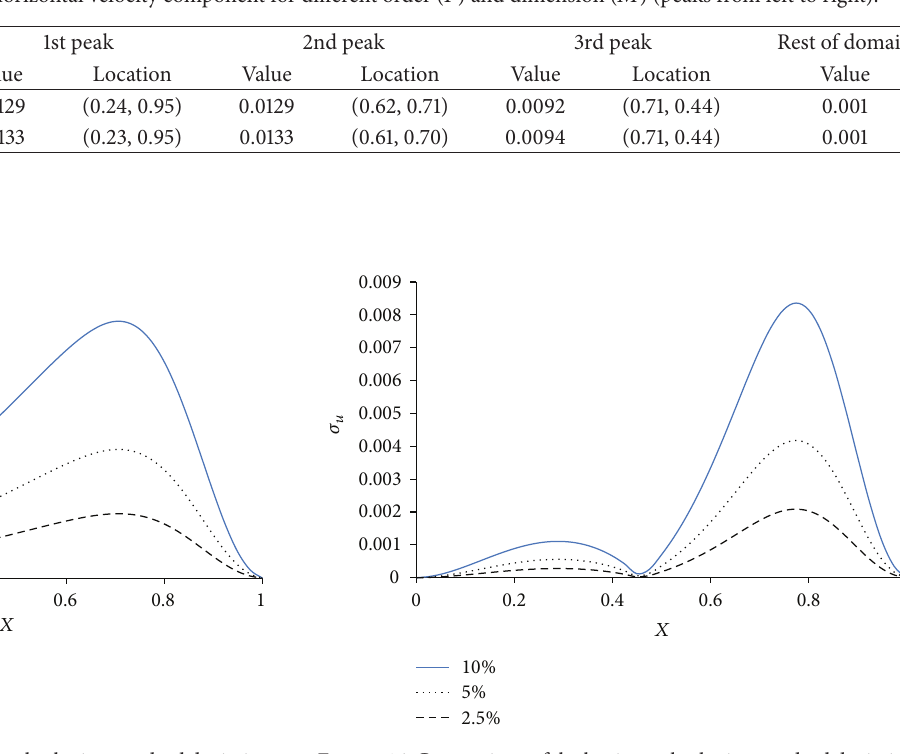
Figure16:Comparisonofthehorizontalvelocitystandarddeviation at the horizontal midline (𝑦 = 0.5) for different values of viscosity standard